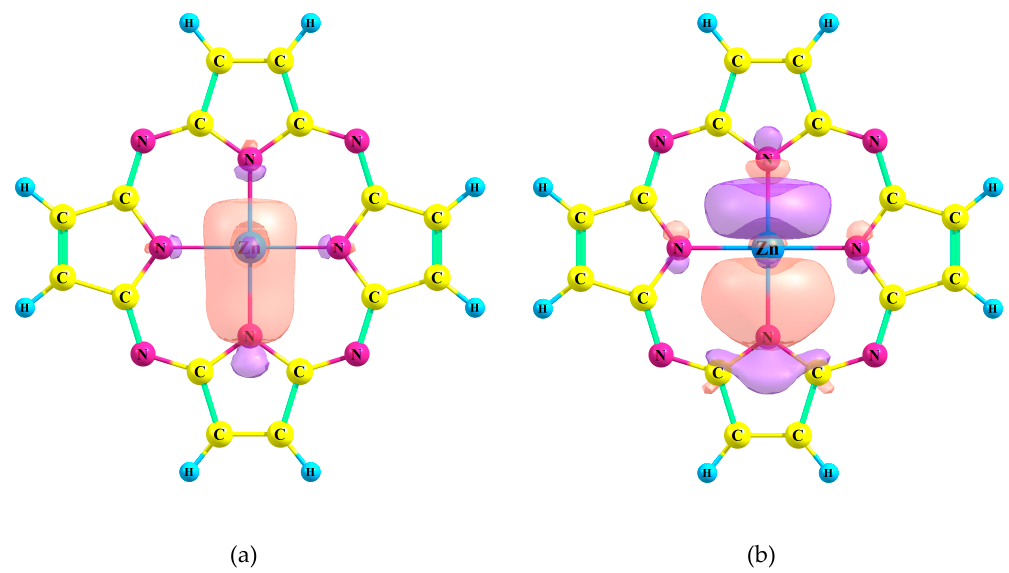
Figure 2. Schemes of the dominant donor-acceptor interactions between Zn and Pz ligand: ( a ) the result of the orbital interaction of the type LP(N) → 4 s (Zn) (E (2) = 54.0 kcal mol − 1 ); ( b ) the result of the orbital interaction of the type LP(N) → 4 p (Zn) (E (2) = 61.9 kcal mol − 1 ). Only one of the four corresponding interactions is demonstrated.